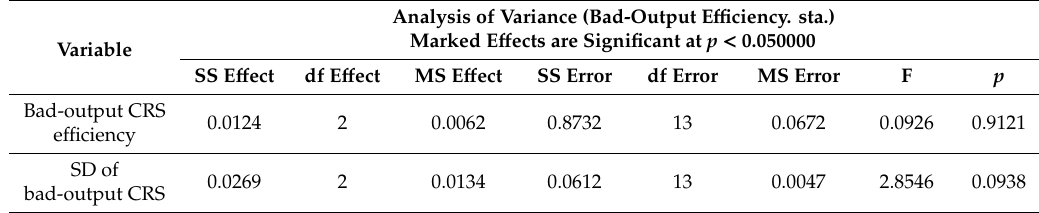
Table 5. ANOVA of bad-output di ff